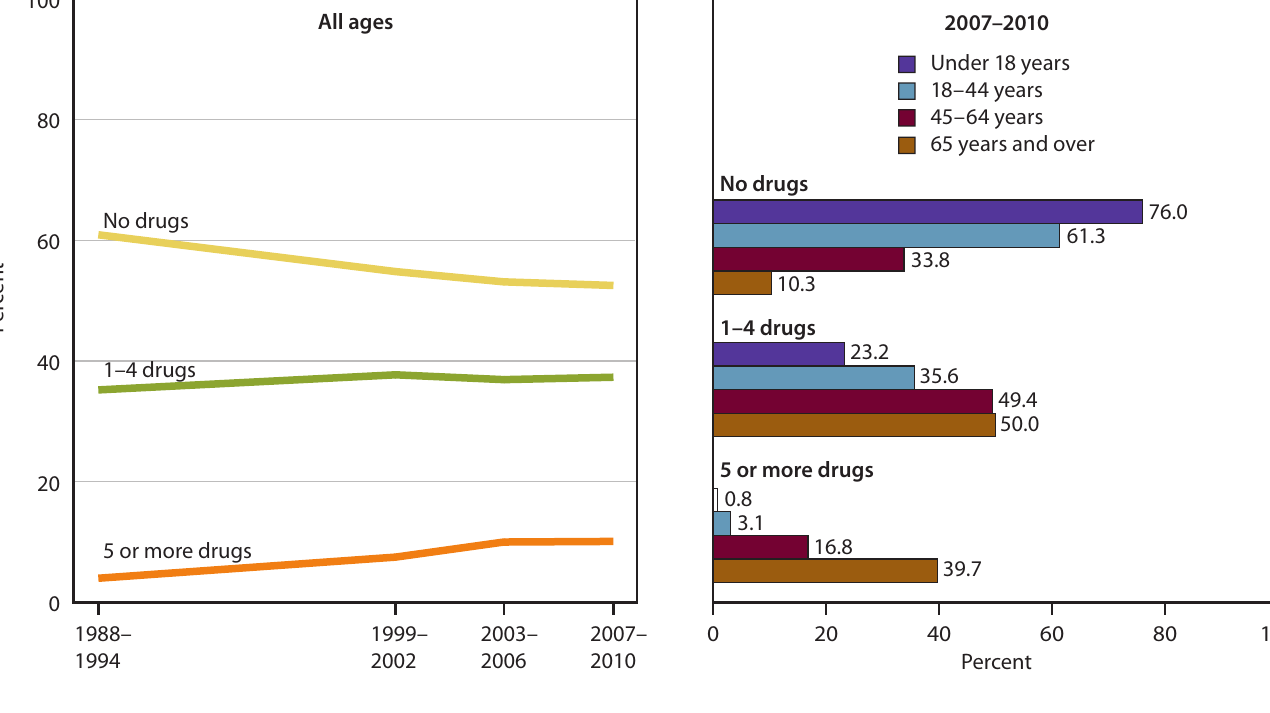
Figure 20. Prescription drug use in the past 30 days, by number of drugs taken and age: United States, 1988–1994